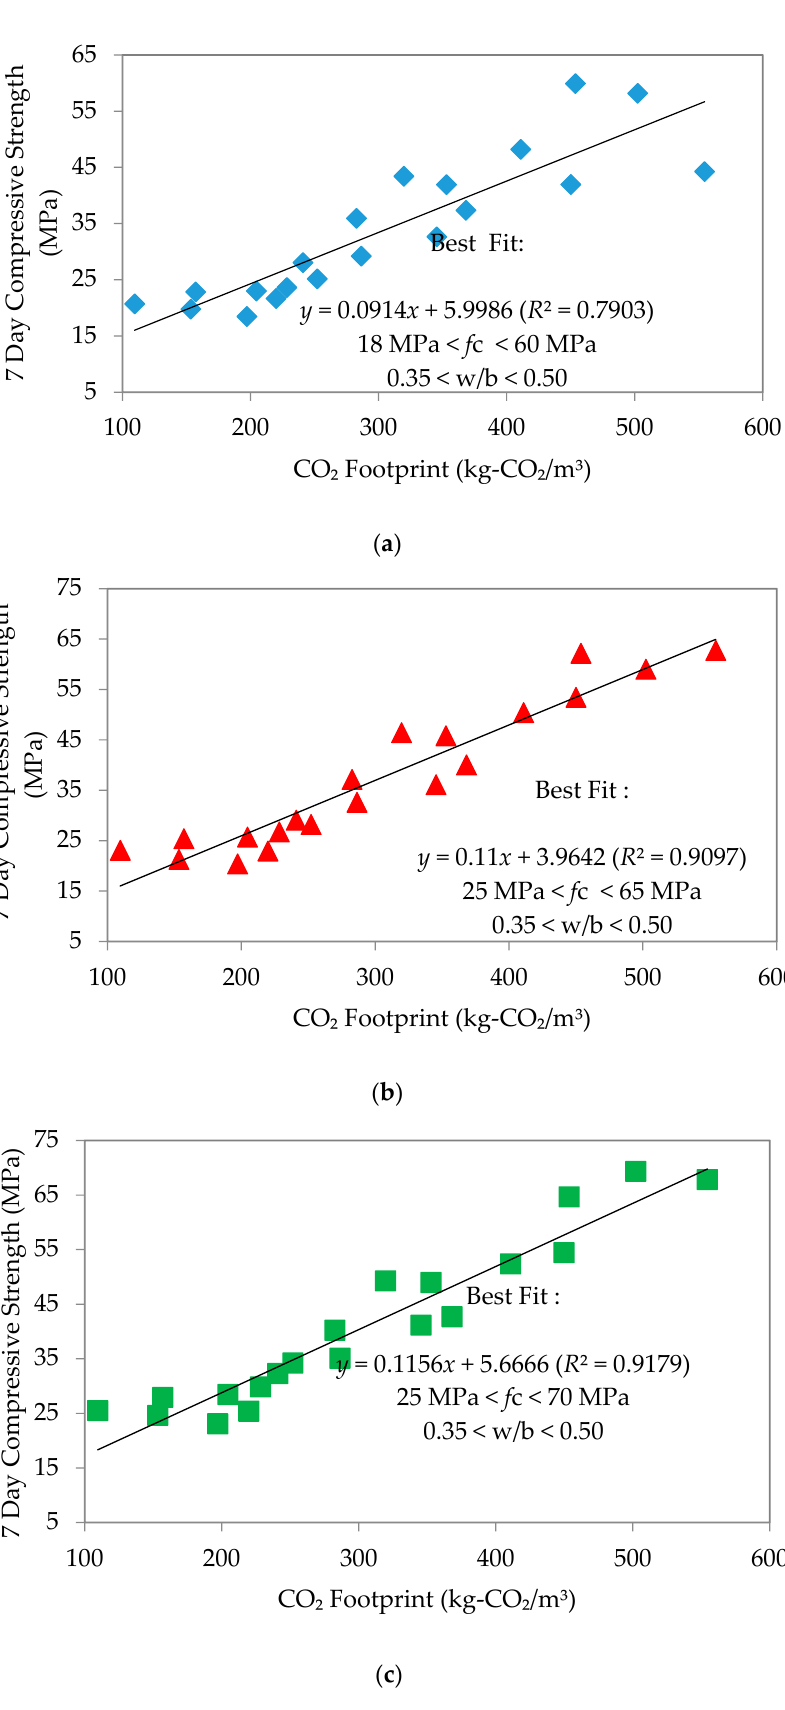
Figure 11. Compressive strength to CO 2 footprint on seven days’ strength. ( a ) Normal flowability; ( b ) High flowability; ( c ) Self-compacting flowability.